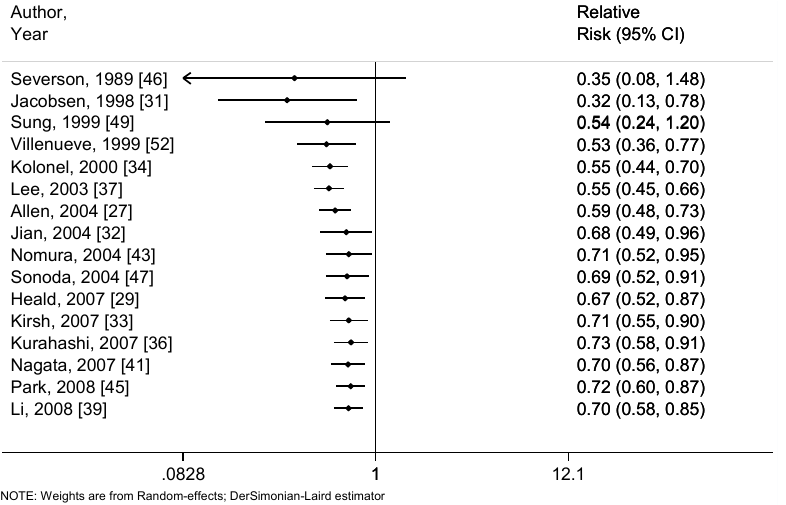
Figure A3. Forest plot for total soy intake and risk of prostate cancer by year of study publication. These associations were indicated as a relative risk (RR) estimate with the corresponding 95% confidence interval (CI).